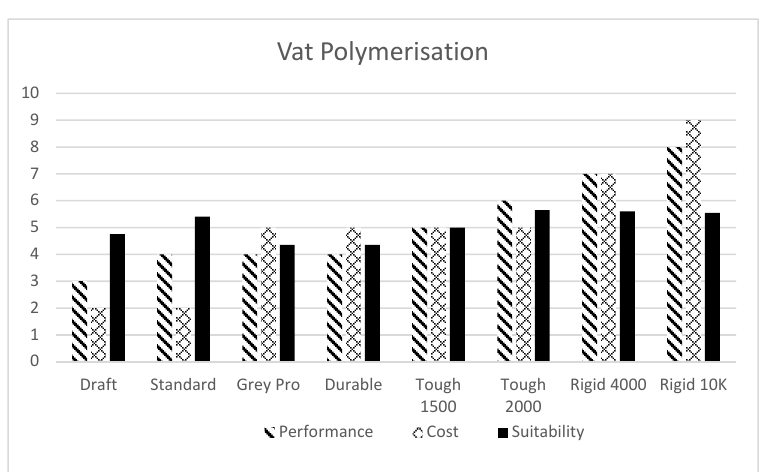
Figure 10. Comparison of various materials [95] available for vat polymerisation AM process.